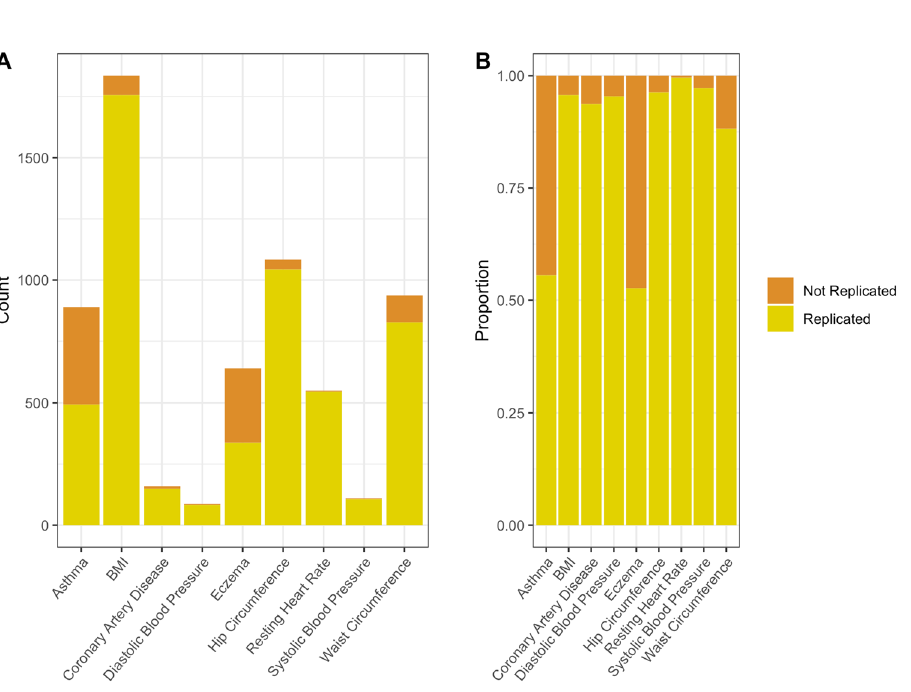
Figure 1. Replication of SNVs across